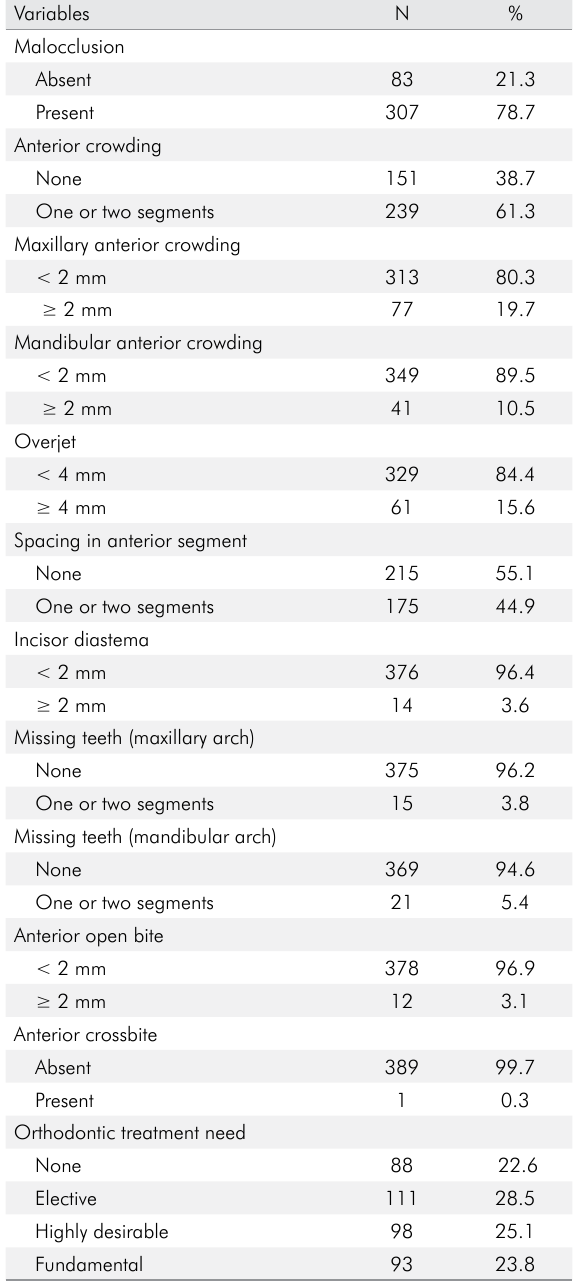
Table 1. Distribution of sample according to type of malocclusion, treatment need, and dentition status (n = 390); Diamantina, Brazil,